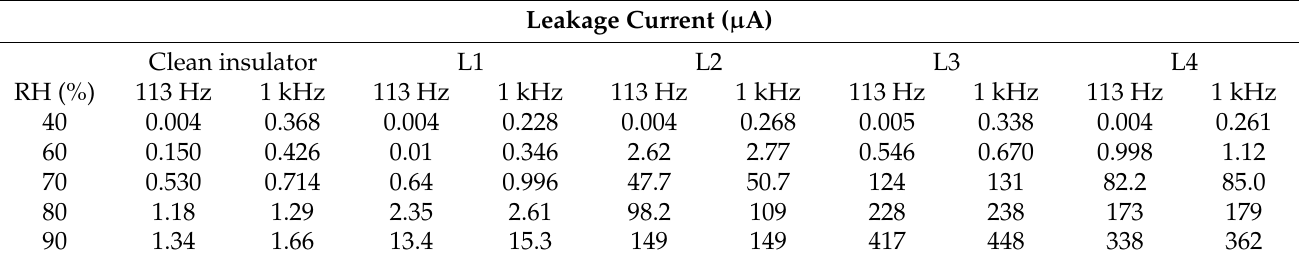
Table 2. Leakage Current Measured Data at Frequencies 113 Hz and 1 kHz.